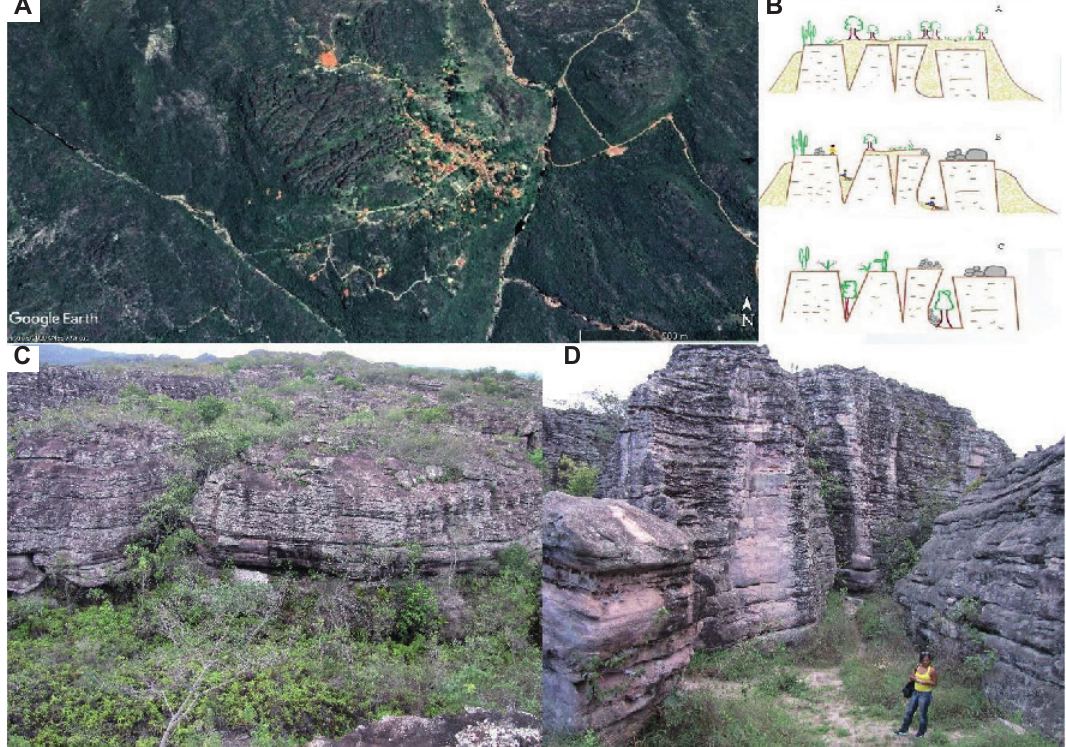
FIGURE 4 . Class 3 Geomineer Heritage. A - the village of Igatu and the anthropogenic landscape generated by the extractive action of the diamond and carbonado (Google Earth 2020). B - an evolutionary scheme of diamond mining action over 200 years and the generation of the current landscape (Russ and Nolasco 2012). C and D - the current landscape of the region, showing the exposure of rocks with shrub cover and arboreal vegetation occupying the depressions caused by the emptying of fractures and removal of colluvial-alluvial material by mining.